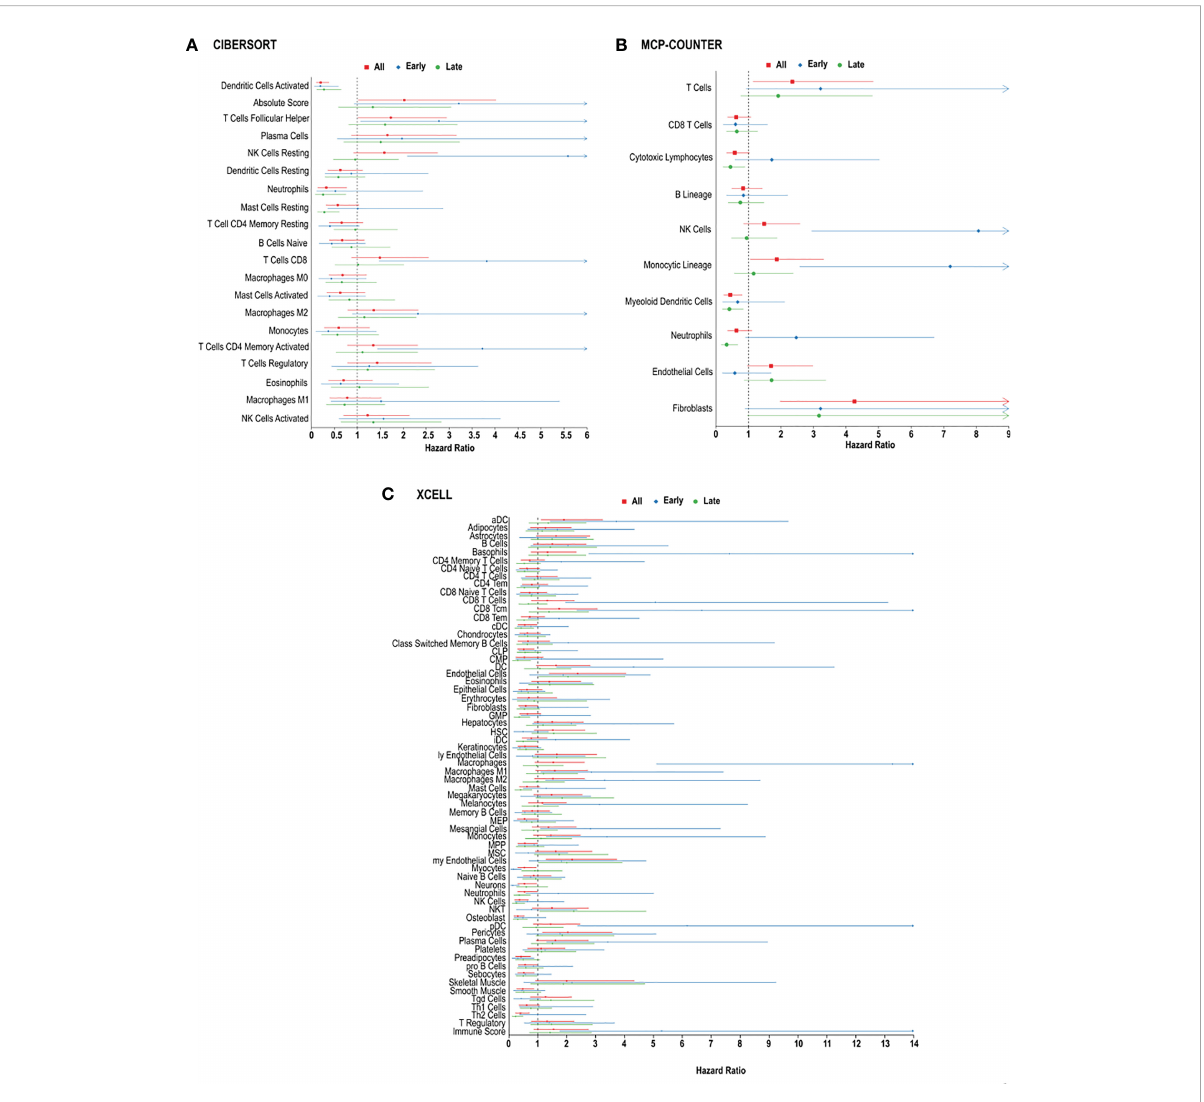
FIGURE 3 Immune cell in fi ltration and survival analysis of CRC. (A) Analysis of prognostic impact of immune cell in fi ltration in all patients, patients with early-stage CRC and late-stage CRC, based on the CIBERSORT analysis. (B) Analysis of prognostic impact of immune cell in fi ltration in all patients, patients with early-stage CRC and late-stage CRC, based on the MCP-counter analysis. (C) Analysis of prognostic impact of immune cell in fi ltration in all patients, patients with early-stage CRC and late-stage CRC, based on the xCell